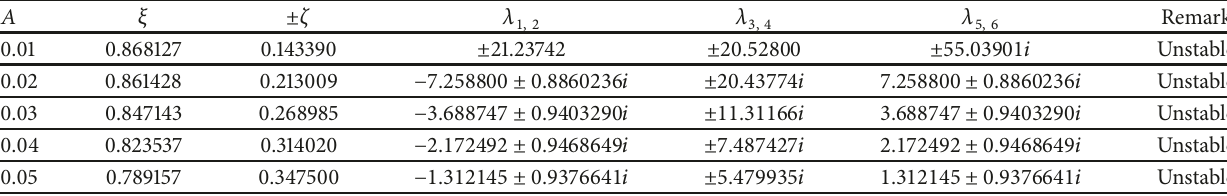
Table 5: Effects of oblateness of DP-Leonis on the locations and stability of out-of-plane points for 𝑎 = 0.95, 𝑒 = 0.2, 𝜎 1 = 0.03 and 𝜎 2 = 0.015.